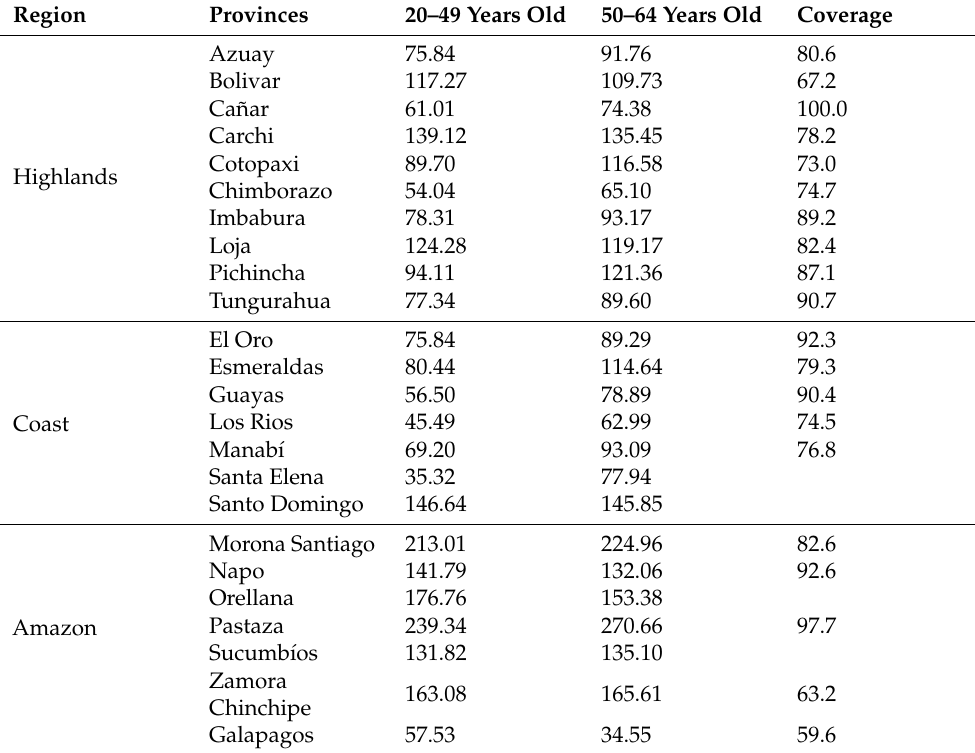
Table 1. Prevalence of COVID-19 cases (per 100,000 inhabitants) by province and age group, and